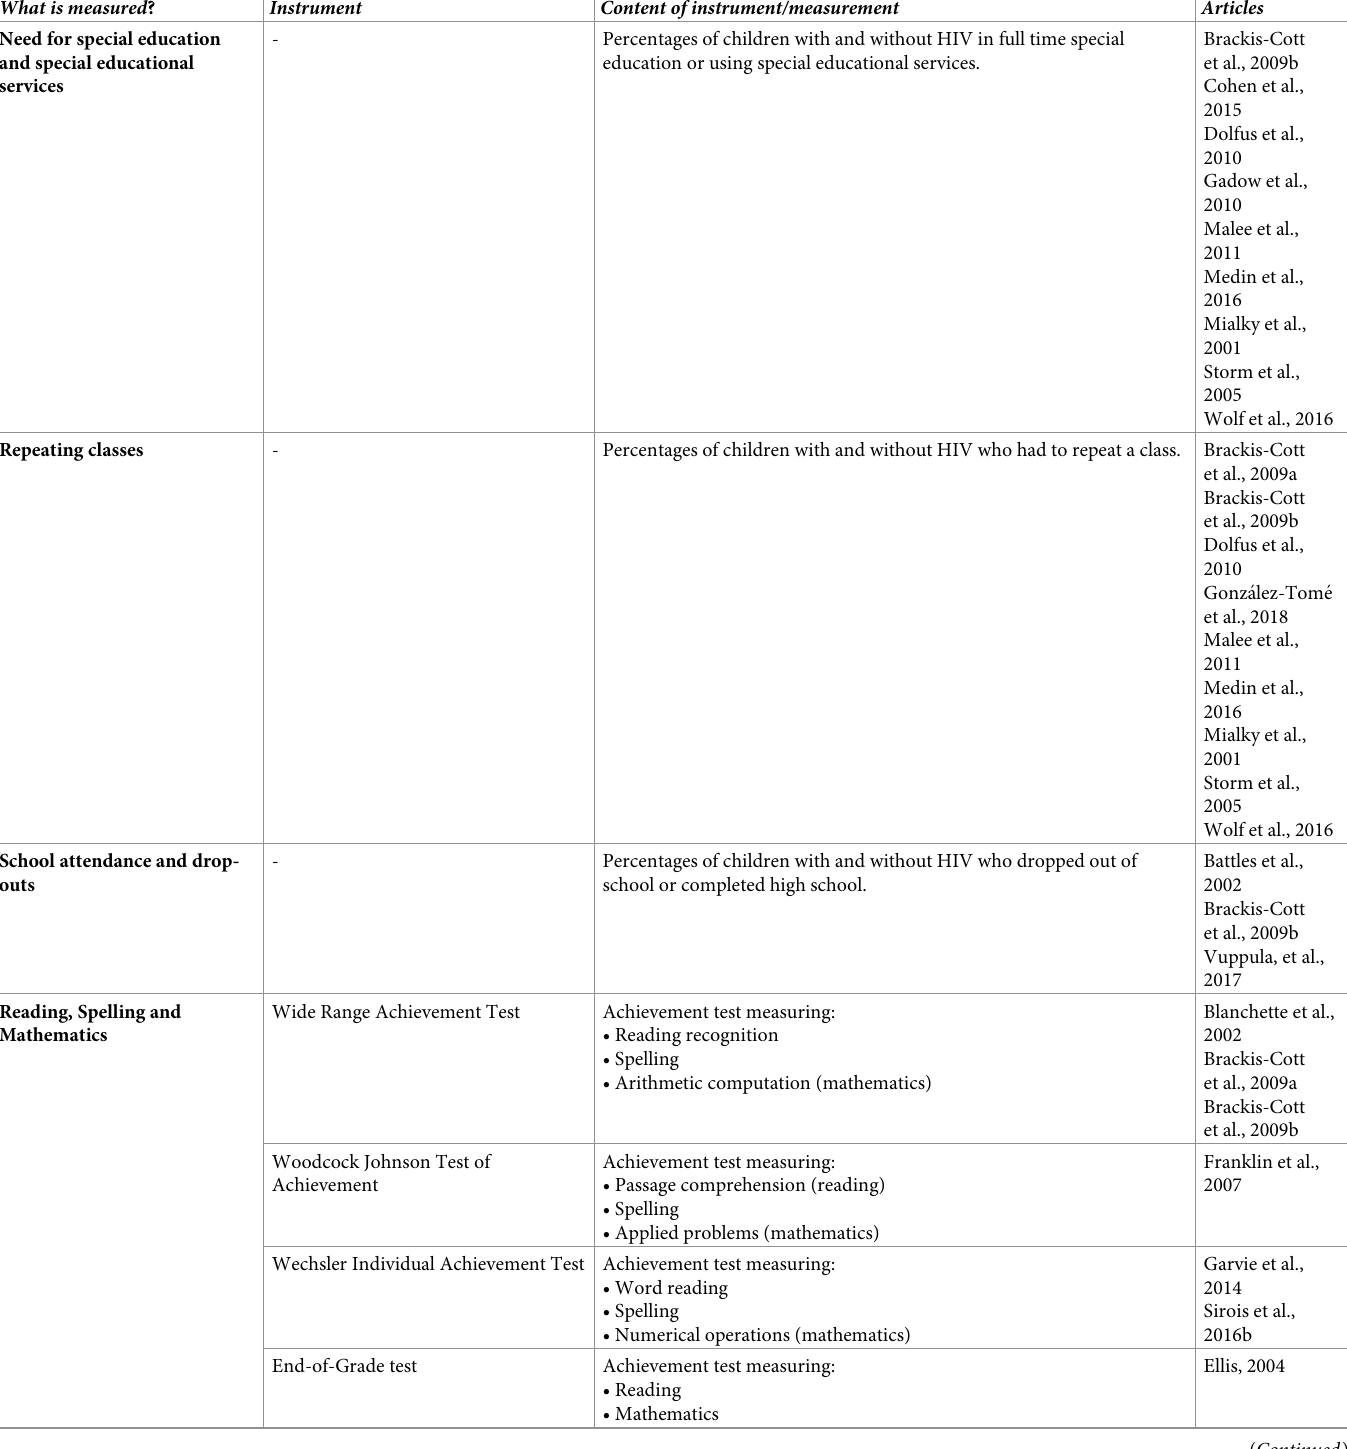
Table 1. Overview of school functioning outcomes and applied